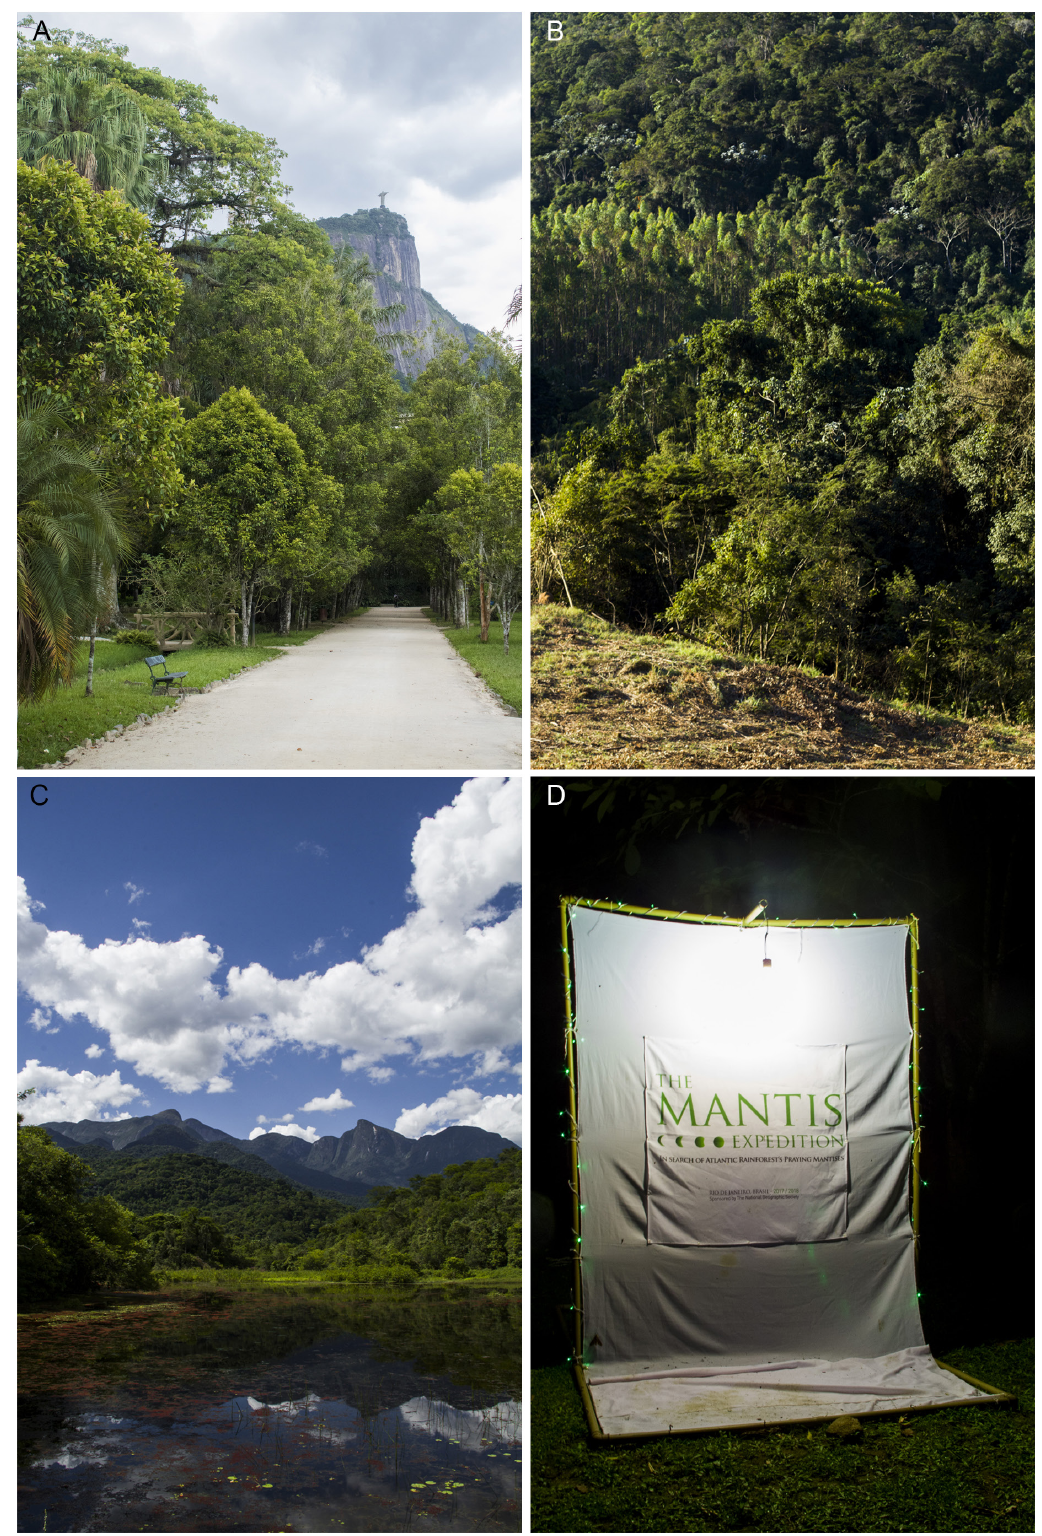
Fig. 1. Habitat of Vates phoenix sp. nov. in the Atlantic Rainforest, highlighting variation across collecting sites. A . Jardim Botânico do Rio de Janeiro. B . Fazenda Recanto, Valença. C . Reserva Ecológica de Guapiaçu, Cachoeiras de Macacu. D . Customized white cloth light trap used to lure adult